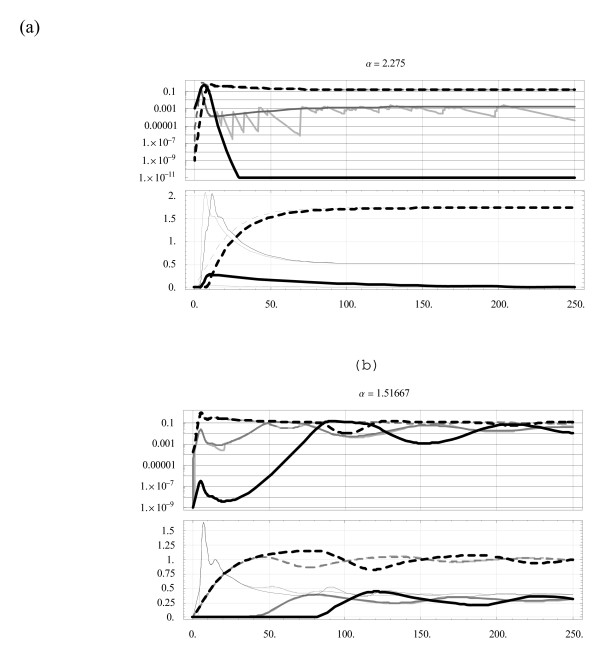
Dynamic histories. Three long-term dynamic histories for 2 cases of Figure 1 over the time range 0 <t < 250 days (horizontal axis). The top plot in each panel shows dimensionless densities of two strains (x(t) – solid, y(t) – dashed), relative to pyrogenic levels xp = yp = 1; the bottom plot shows their immune effectors, I(t) – thin, J(t) – solid thick, K(t) – dashed, weighted by their respective efficiencies en;eX;eY. For each panel, the shading (black, heavy gray, light gray) corresponds to the case of 'no-source', 'stationary source', 'stochastic source'. Note that 'y-curves' (dashed) are essentially the same in all 3 cases, leaving y unaffected, while x is strongly affected by the 'stationary' and 'random' sources.